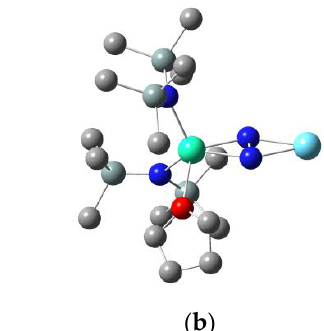
cyan; La, turquoise; C, gray; N, blue; O, red; Si, blackish green. All hydrogen atoms are omitted